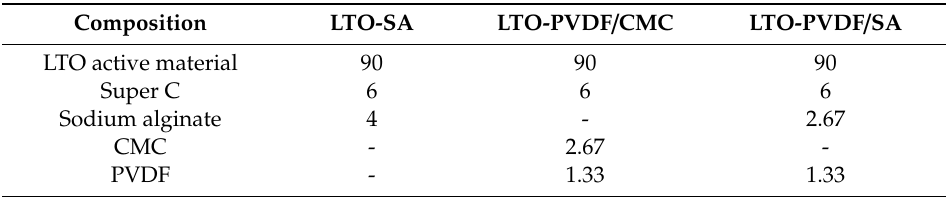
Table 1. Formulation of LTO